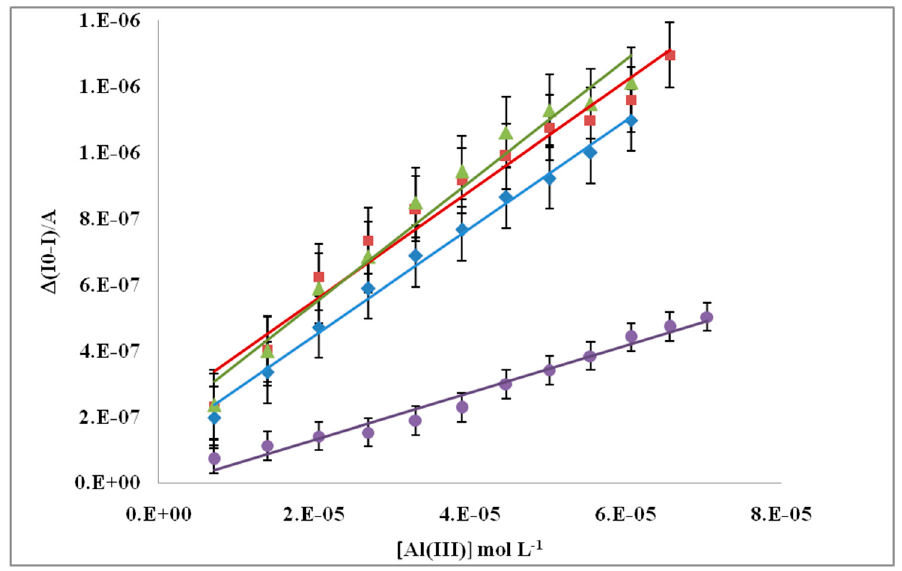
Figure 5. Calibration curves of Al(III) inhibition for ( ▲ ) SOD/RhNPs/SPC TTF Es; ( ■ ) SOD/PdNPs/SPC TTF Es; ( (cid:7) ) SOD/PtNPs/SPC TTF Es and ( • ) SOD/AuNPs/SPC TTF Es performed with NPs/SPC TTF Es prepared under CV1 condition, [EPI] 1.6 × 10 − 4 M, Britton Robinson buffer pH 5.0, Eap = +0.2 V vs. Ag/AgCl.